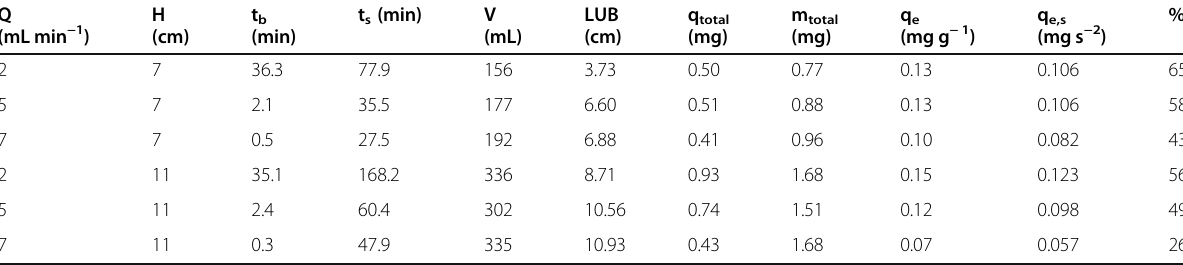
Table 6 Operating parameters of the adsorption column with the corn